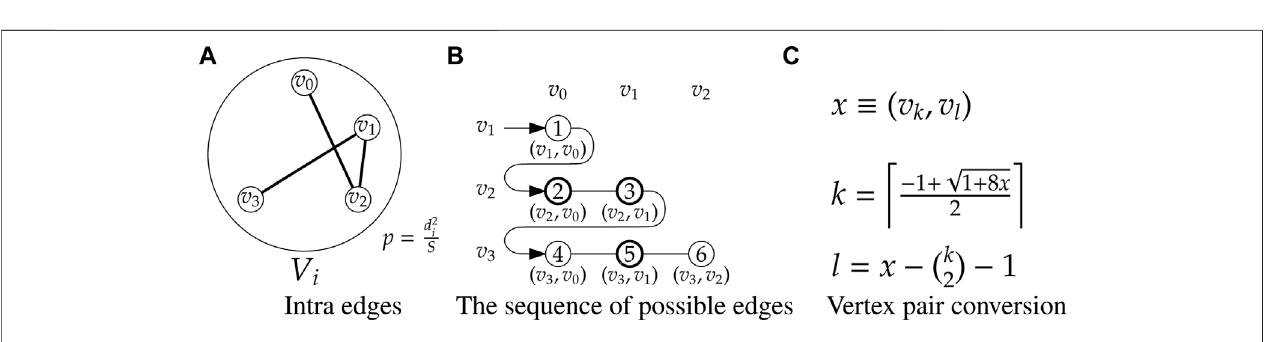
FIGURE 2 | Illustration of intra edge sequences with a group V i using G ( n , p ) model with n i (cid:1) 4 and p (cid:1) d 2 i